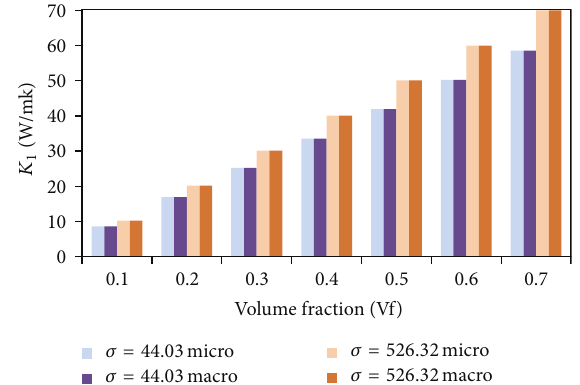
Figure 13: Variation in 𝐾 1 with respect to Vf of a composite with alternate layers of fibres fully